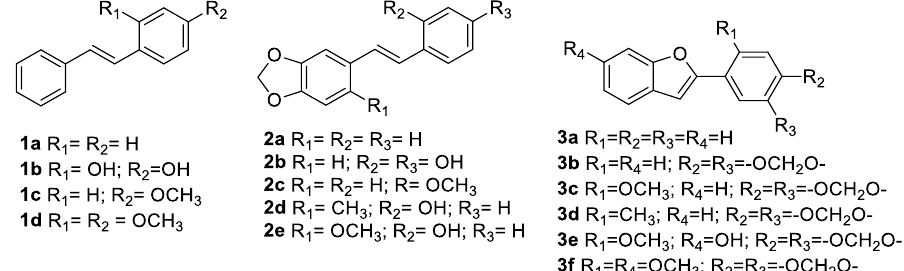
Figure 2. Structures of cicerfuran and synthetic analogues from Aslam et al. (2009) [52]. Table 5. MIC values of cicerfuran and its analogues from Aslam et al. (2009) [52]. Compound